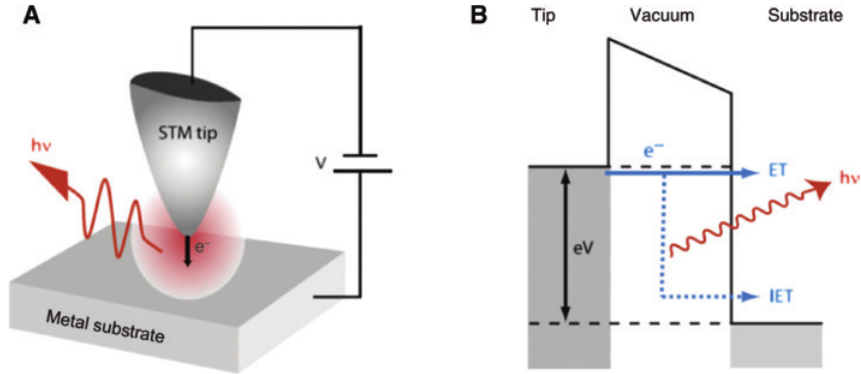
Figure 3: Illustration of the electrical excitation process by tunneling electrons. (A) The tunneling current in an STM can be used as a nanosource to generate light from the tunnel junction. (B) Schematic potential energy diagram illustrating the mechanism for photon emission in an STM junction. Elastic (ET) and inelastic tunneling (IET) processes are indicated. IET excites a LSP between tip and sample. The photons emitted during the radiative decay of the plasmon are detected in the far field, reprinted from Ref. [3] copyright (2010), with permission from